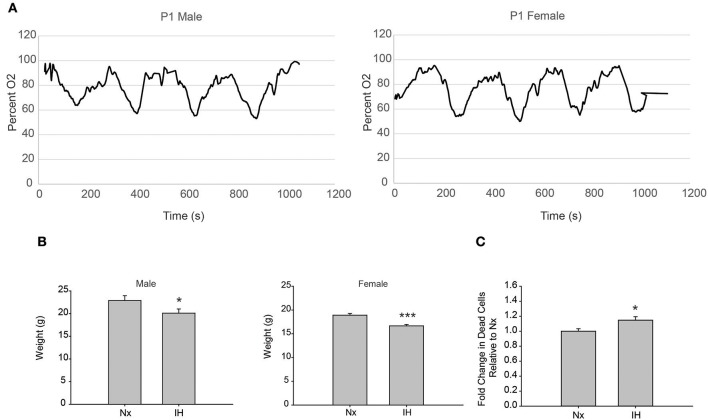
Neonatal IH decreases SpO2 and weight. (A) Pulse-oximetry was recorded in P1 neonatal males (left) and females (right). (B) At P9, after 8 days of Nx or IH exposure, male (left; n = 20/tx) and female (right; n = 20/tx) pups were weighed. (C) At P9 after 8 days of Nx or IH exposures, whole brains from male (n = 6/treatment) and female (n = 6/treatment) pups were isolated for flow cytometric analysis of cell death. *p < 0.05, ***p < 0.001, t-test.